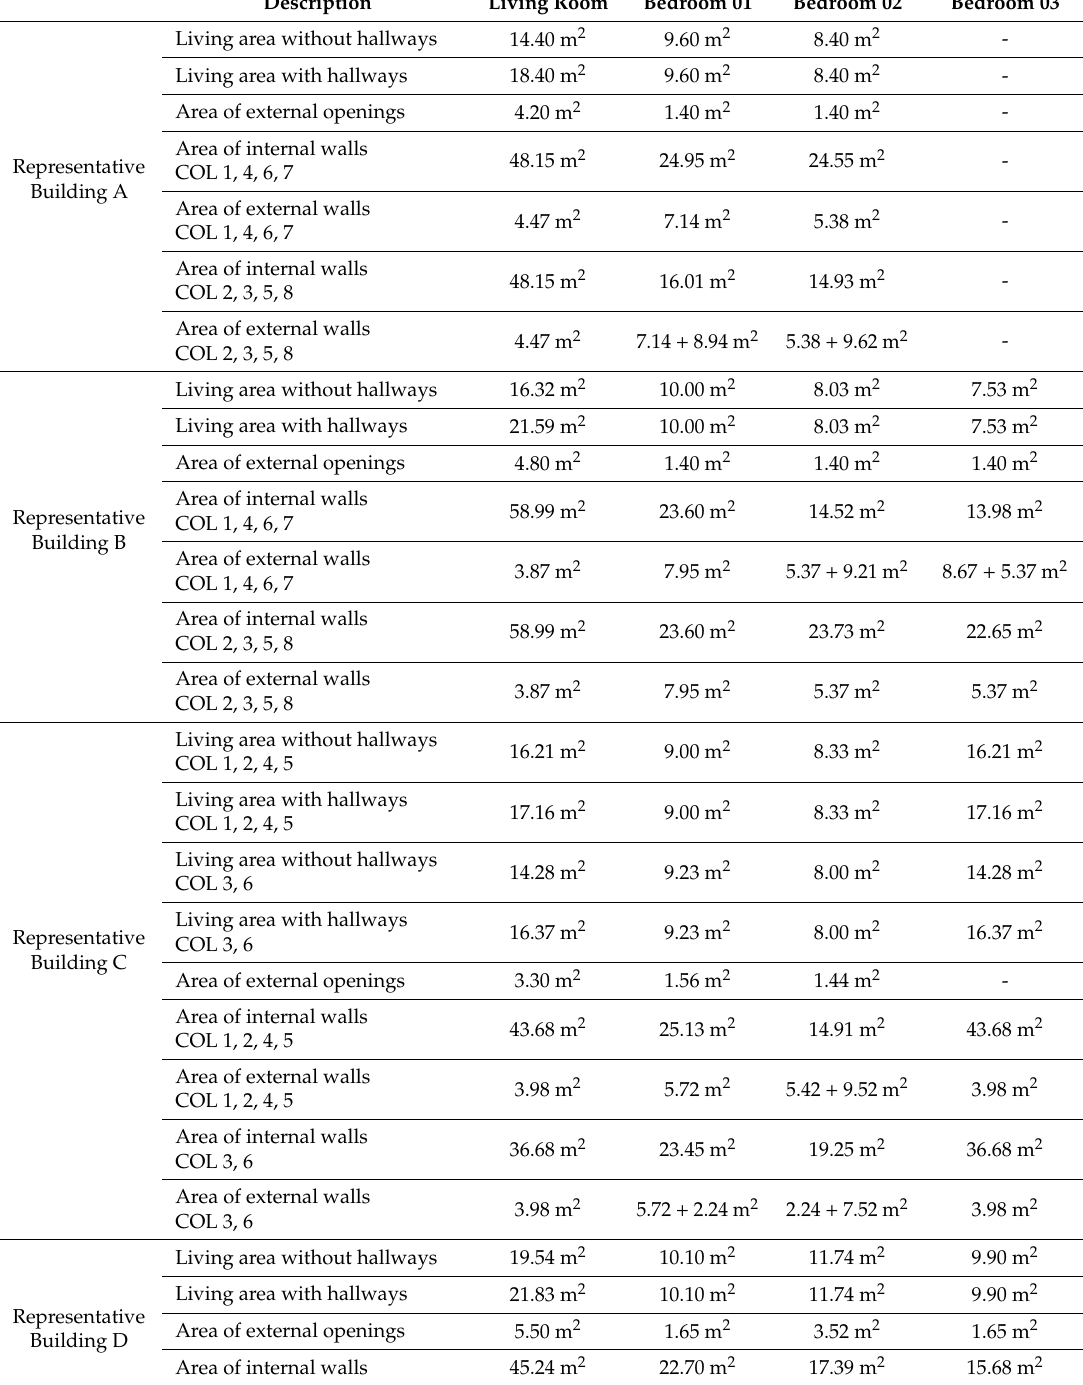
Table 2. Areas of spaces and walls of representative